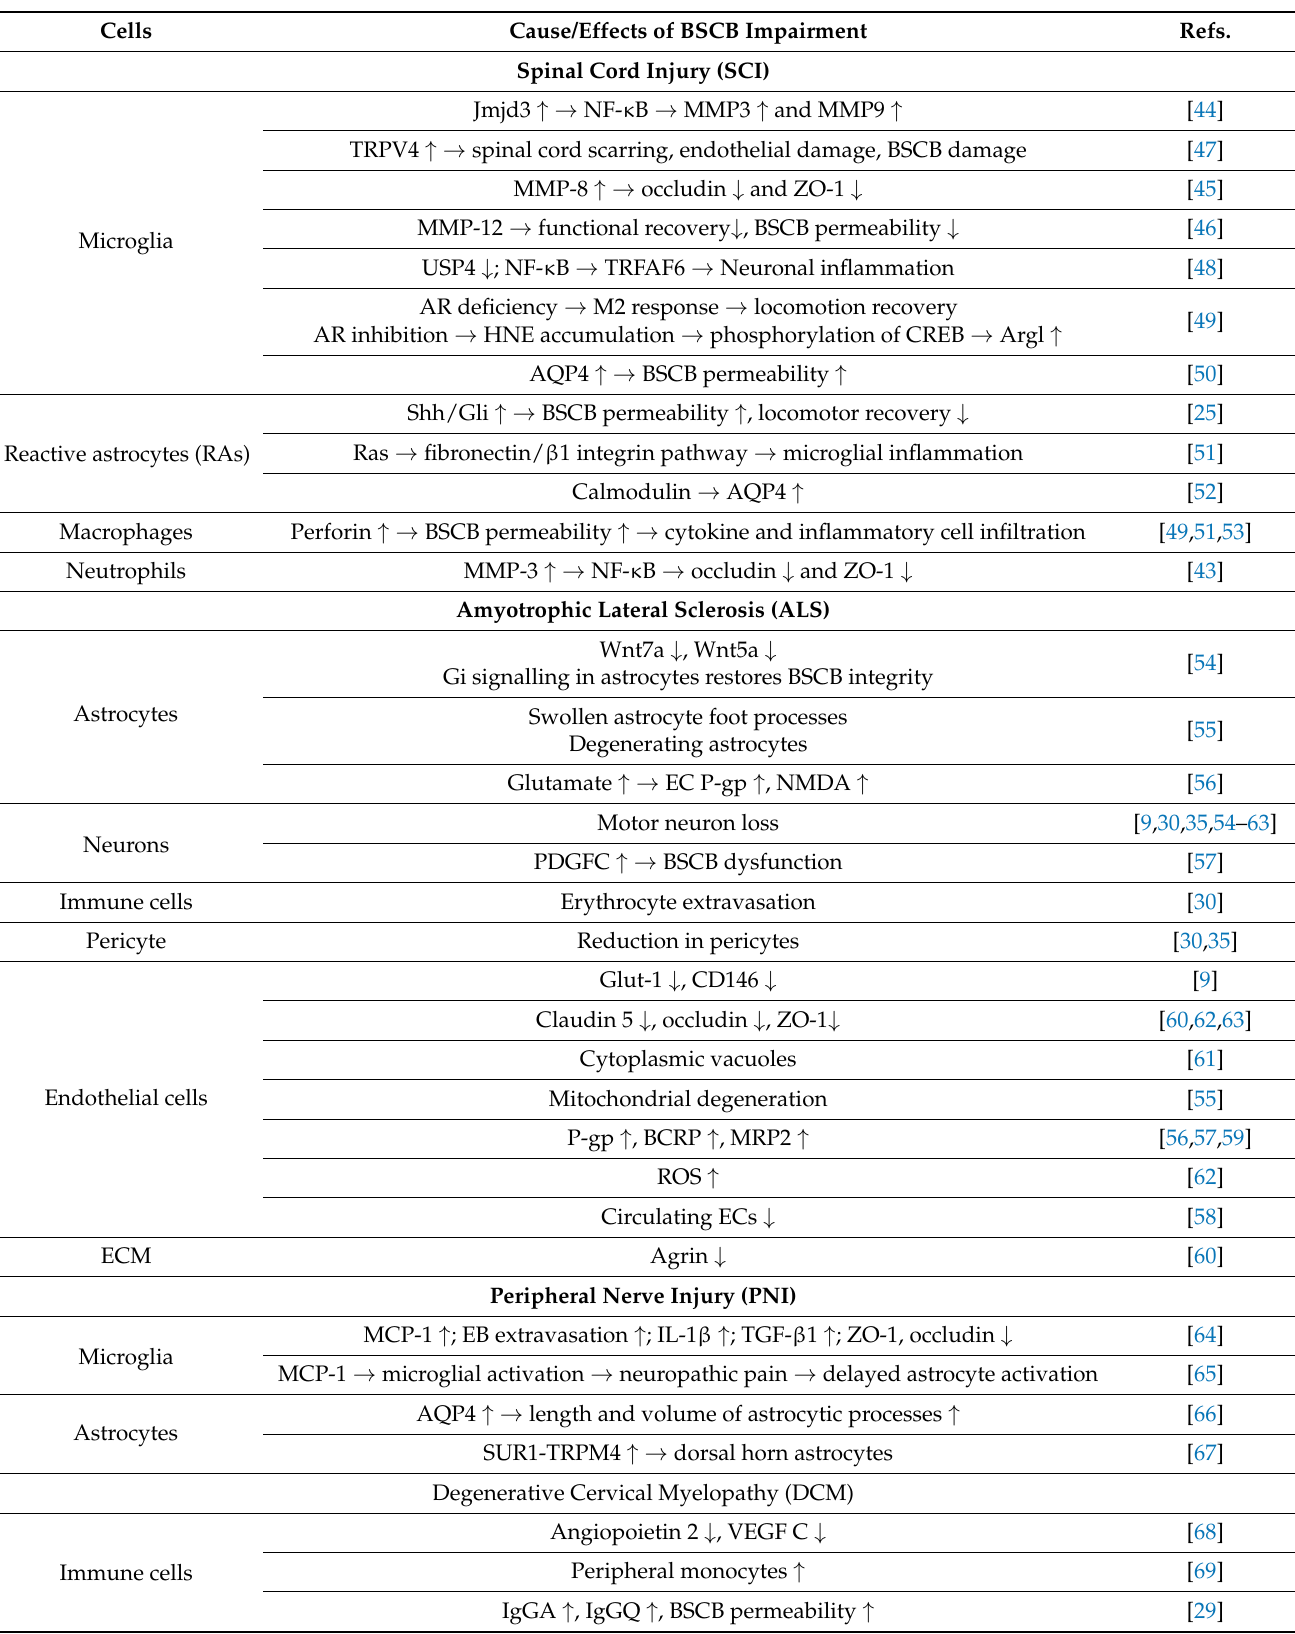
Table 2. Implications of blood-spinal cord barrier dysfunction in different spinal cord